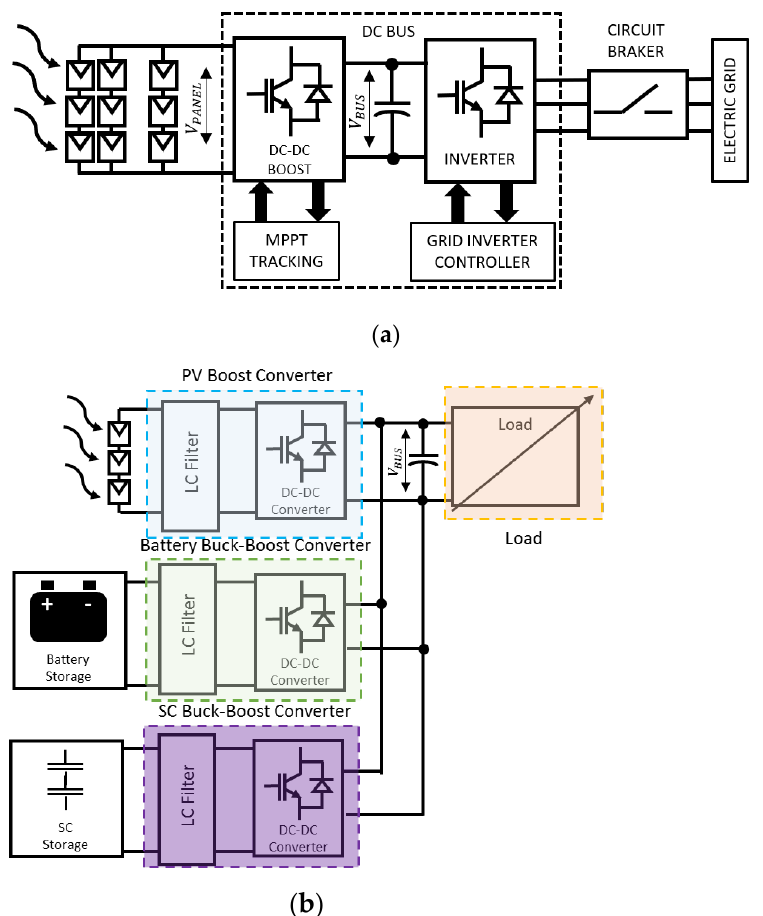
Figure 15. ( a ) Simplified electrical diagramam of grid connected double conversion PV system; ( b ) Structure of a multiple converters configuration with maximum power point tracking (MPPT) adapted from [62].